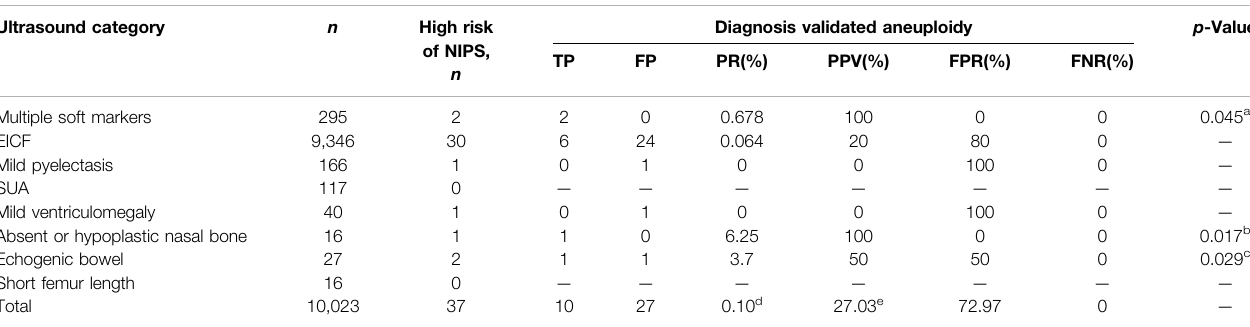
TABLE 4 | Characteristics of aneuploidy among the fetuses with USM. Ultrasound category